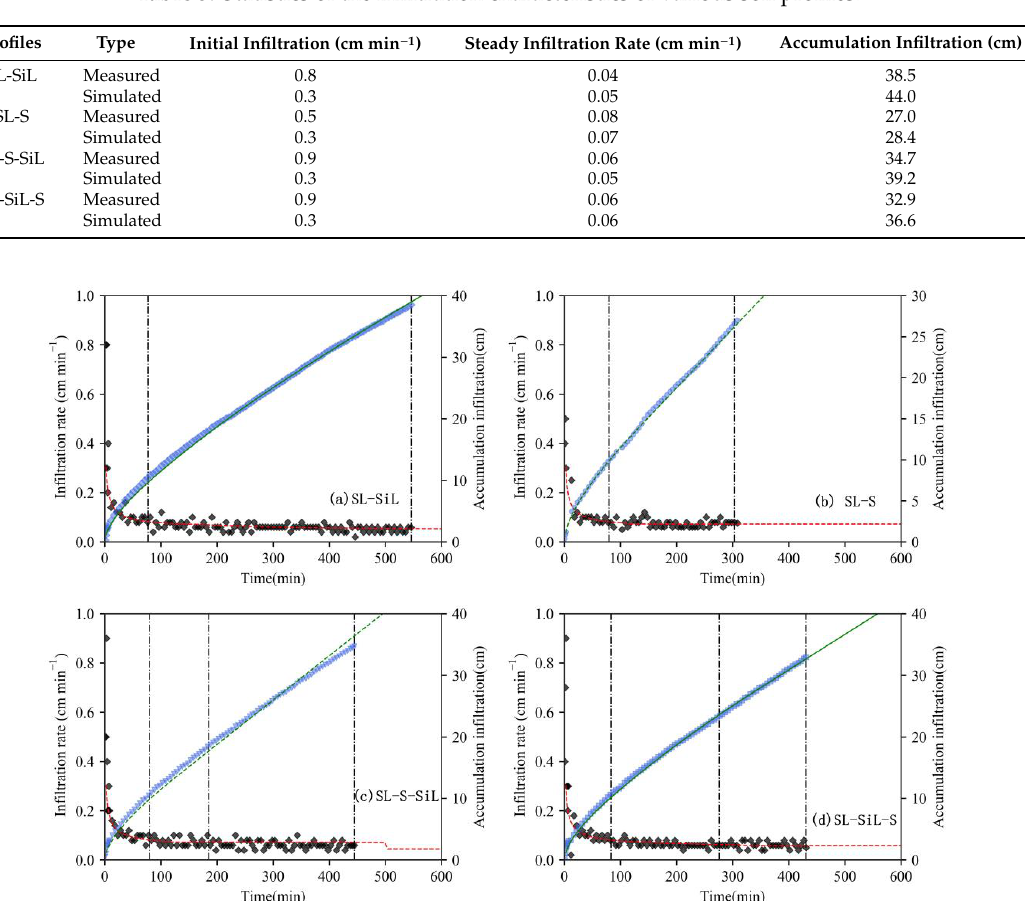
Table 5. Statistics of the infiltration characteristics of various soil profiles.